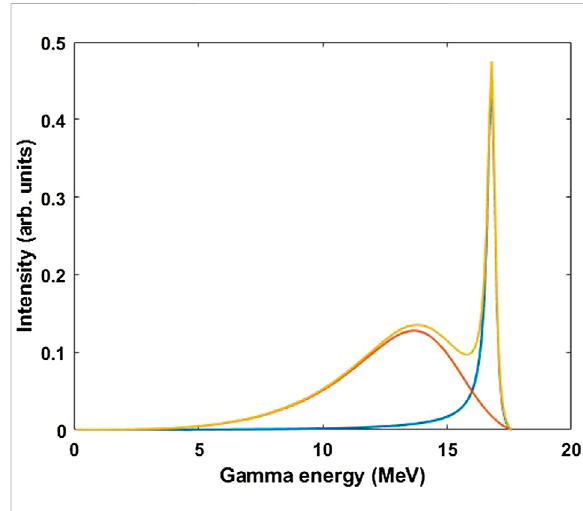
FIGURE 6 DT gamma spectrum used for weighting the DAD response function to determine a DT gamma-to-neutron branching ratio. Data from Ref. 24 has been reproduced with the permission of the corresponding